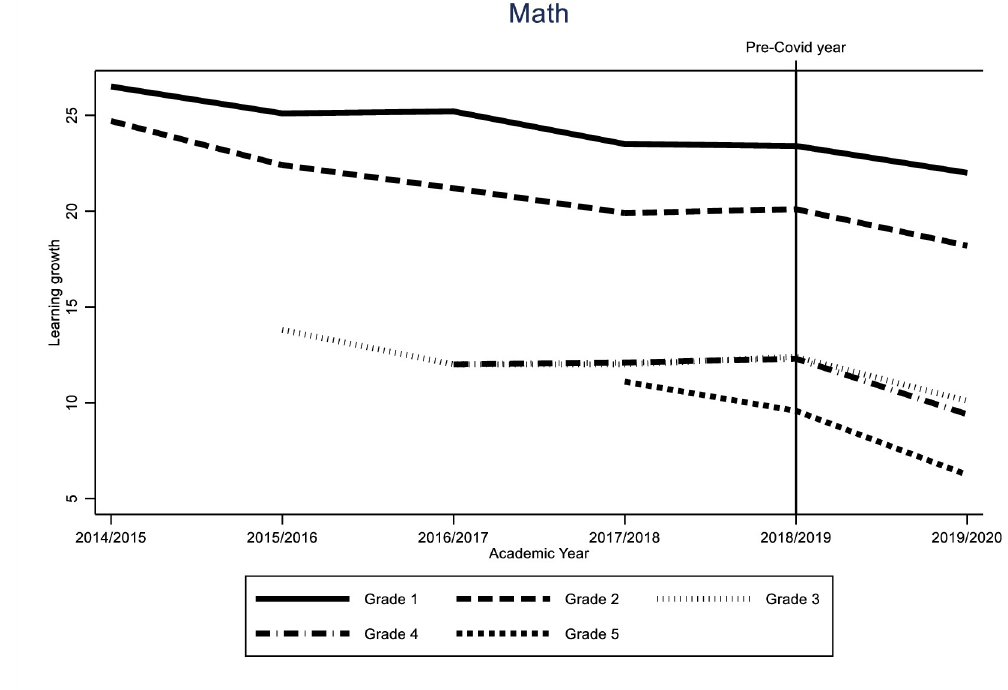
Fig 7. Trends in learning gain over